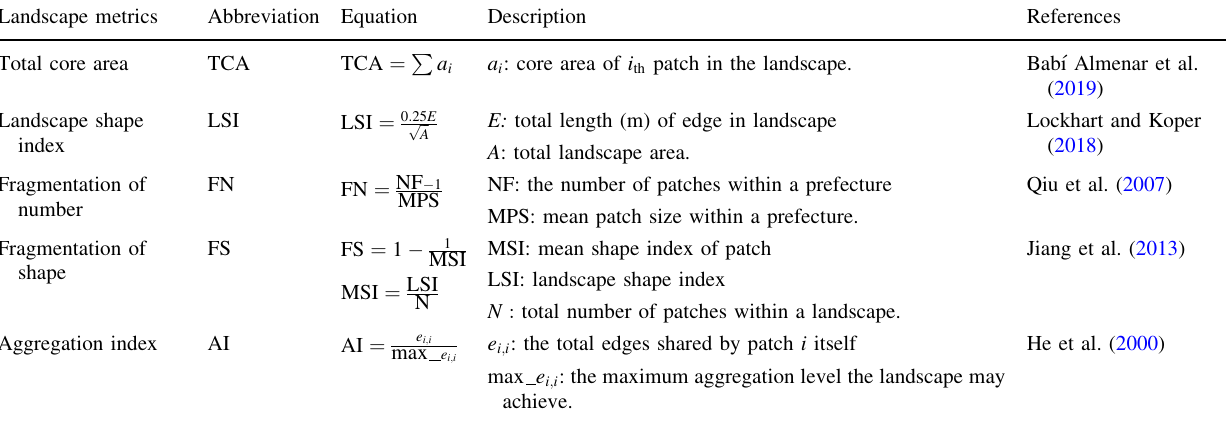
Table 2 Landscape metrics and their explanations Landscape